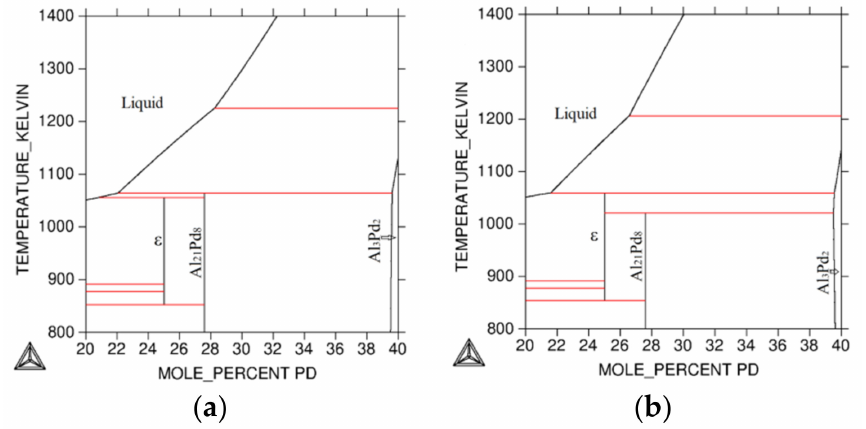
Figure 4. Detail of the calculated Al–Pd diagram ( a ) according to study [18]; ( b ) according to this work with respect to the experimental results from